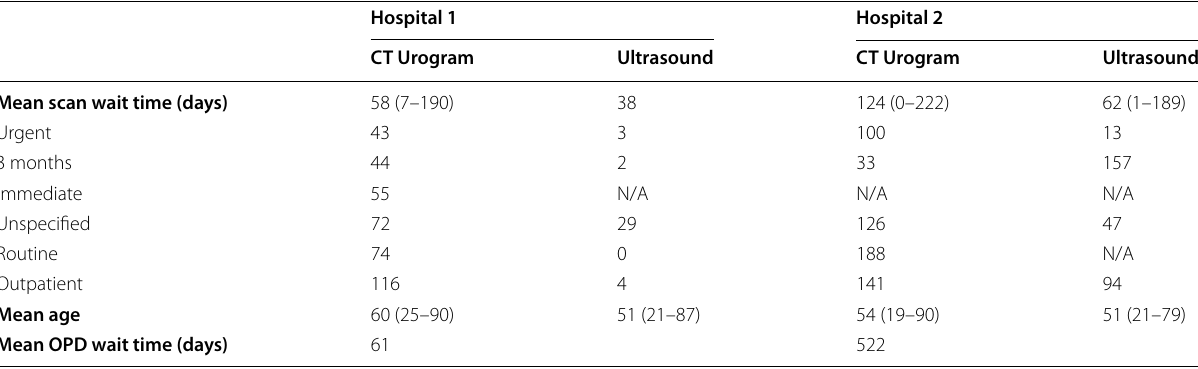
Table 2 Mean imaging and outpatient wait